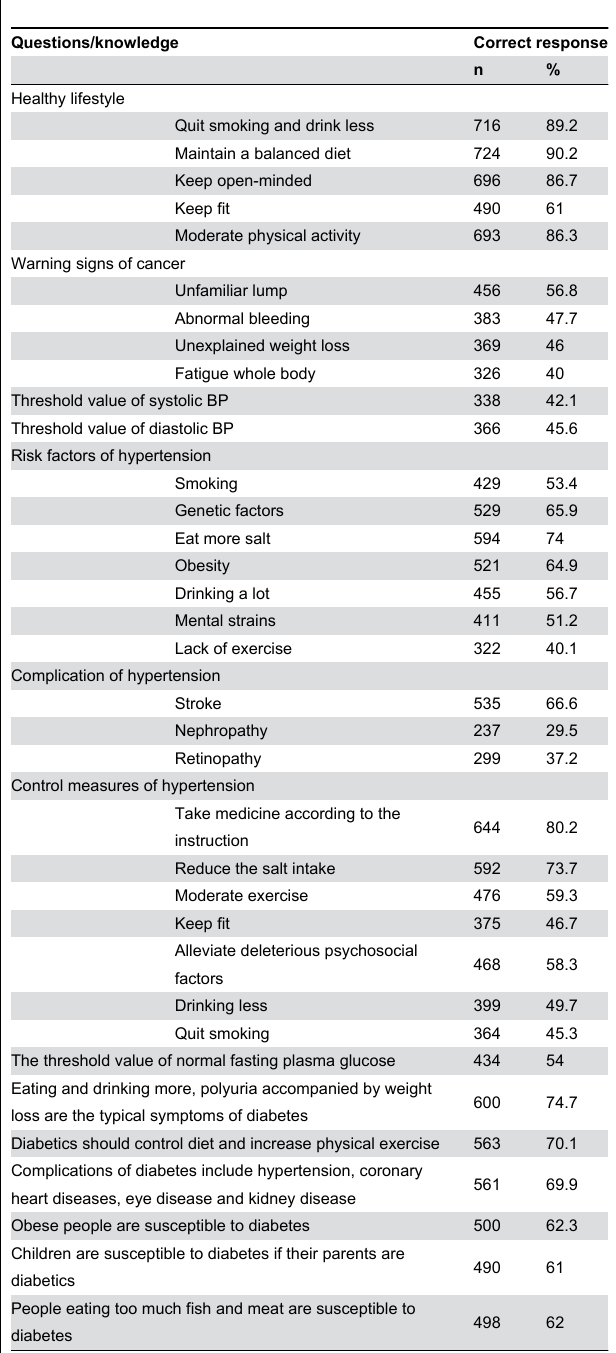
Table 2. Awareness rates of chronic diseases knowledge among the elderly in